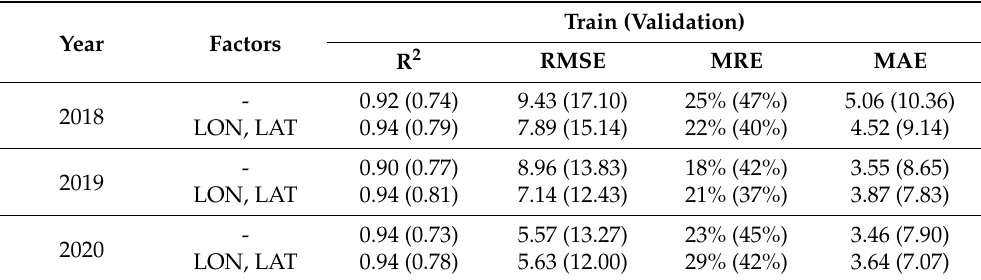
Table 3. Comparison validation of the DNN model fitting accuracy with and without longitude and latitude (2018–2020).